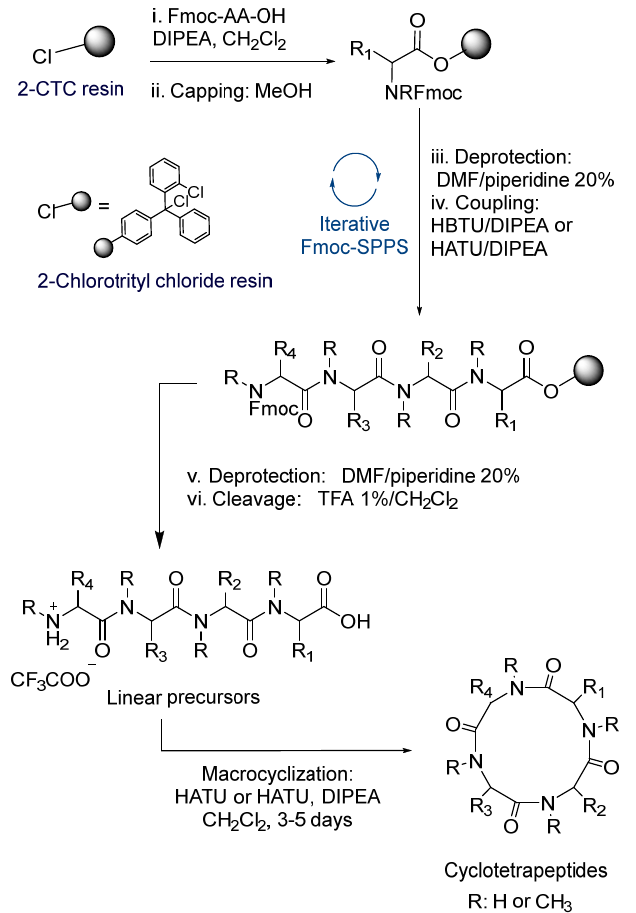
Table 1. Linear peptides obtained by Fmoc- SPPS